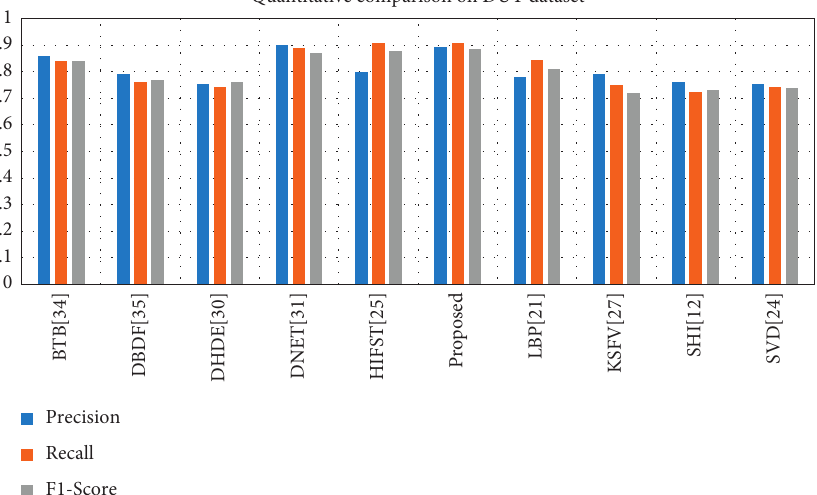
Figure 9: Quantitative comparison on the DUT